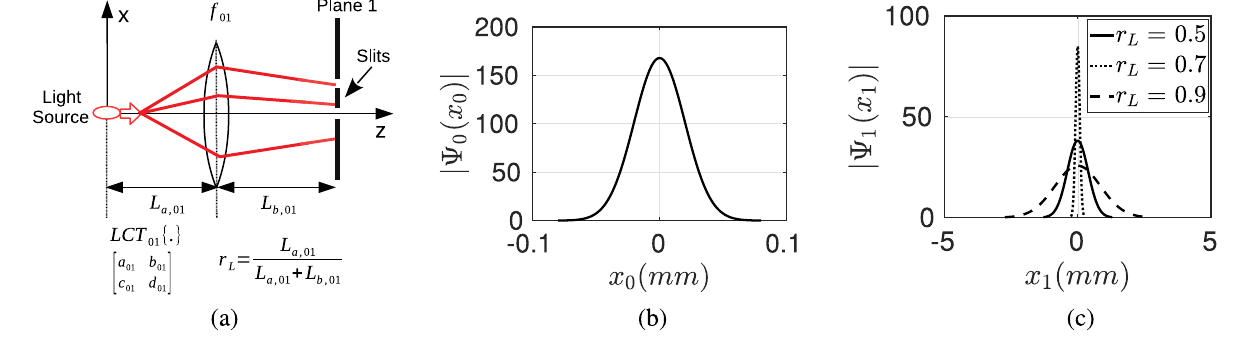
Figure 4. ( a ) The set-up with a single thin-lens of focal length 60 (mm), ( b ) Gaussian source with σ 0 650 (nm), and ( c ) the distribution of the wave function on the first plane by shifting the ( µ m) and (cid:31) = lens inside the spatial interval of fixed total length L 01 r L L a ,01 /( L a ,01 L b ,01 ) = +